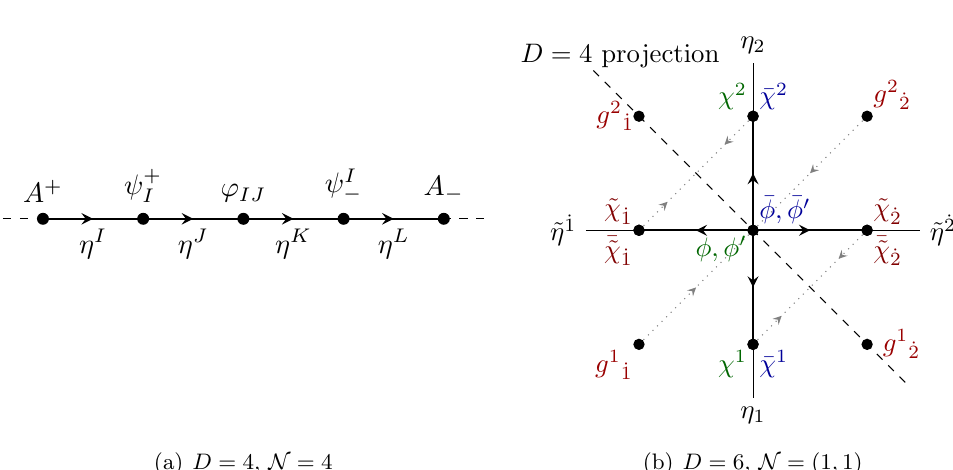
Figure 1 . Weight-space diagrams for states in the (a) D = 4, N = 4 and (b) D = 6, N = (1 ; 1) vector multiplets transforming under the little groups U(1) and SU(2) (cid:2) SU(2) respectively. The Grassmann variables (cid:17) and ~ (cid:17) act as raising and lowering operators in the weight space [87] as denoted by solid black arrows. Red-colored states belong to the vector multiplet; green- and blue- colored states belong to the two parts of the D = 6, N = (1 ; 0) hypermultiplet. The dotted gray arrows show how 6D states are projected to the four-dimensional weight